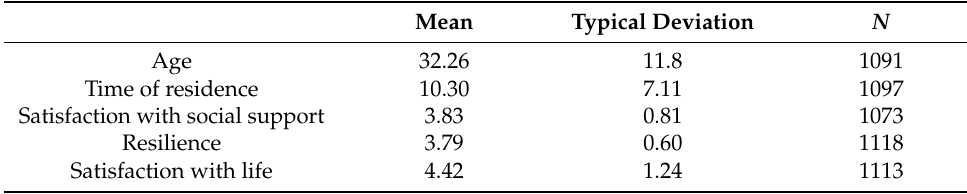
Table 2. Descriptive statistics of psychosocial and sociodemographic variables.